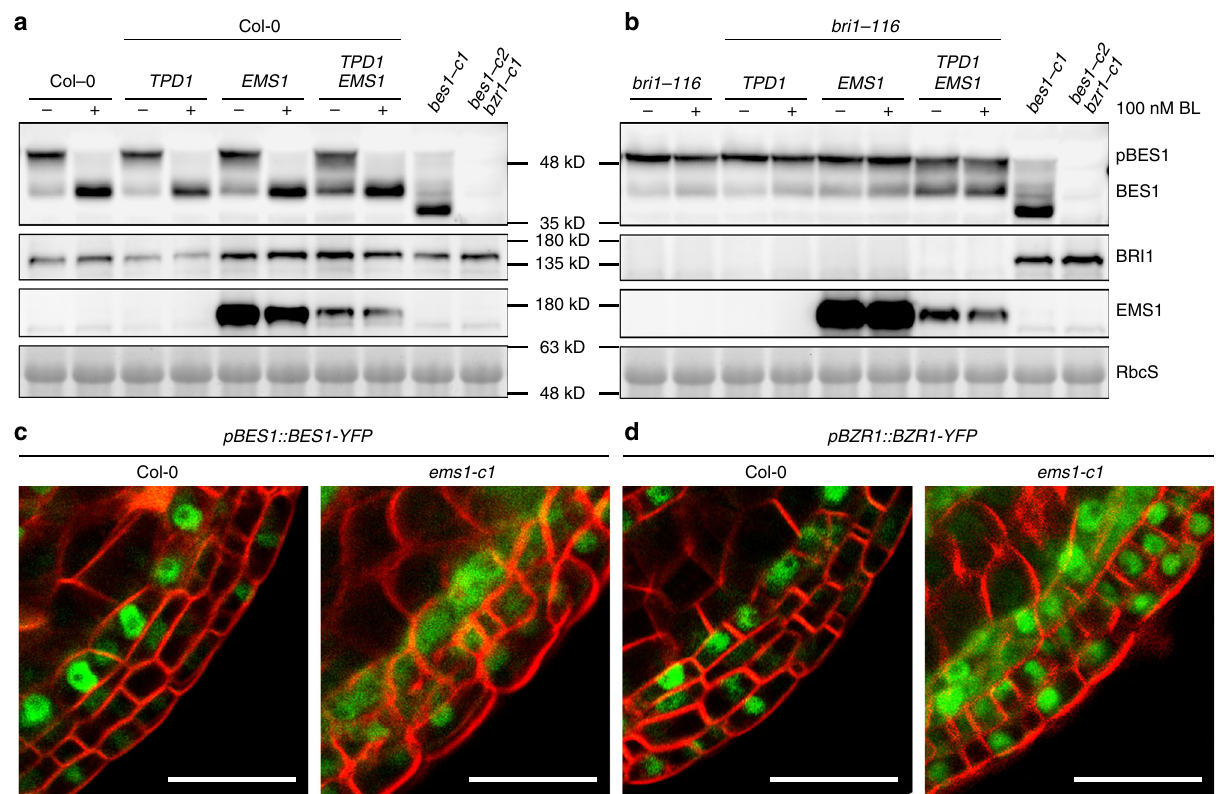
Fig. 7 BES1 can be activated by the EMS1-TPD1-SERK1/2 signaling pathway. a Immunoblotting analyses using transgenic plants harboring